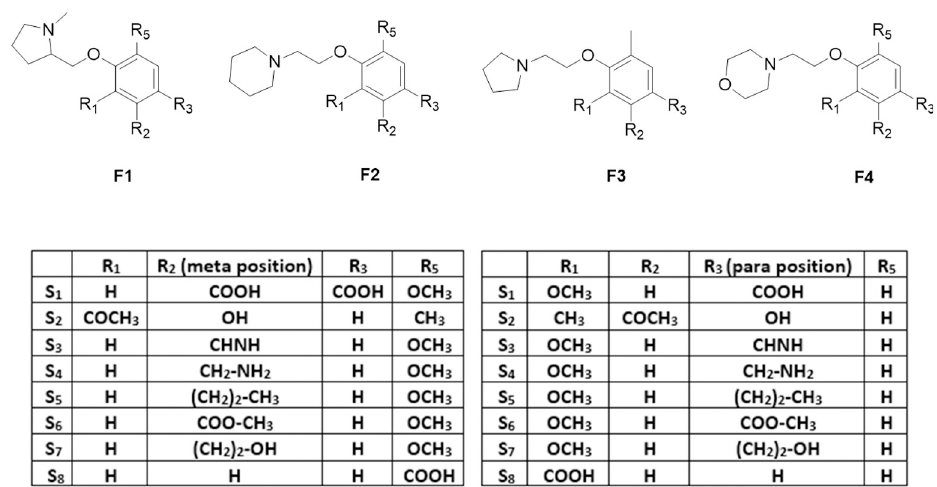
Fig 1. Chemical structures of ligands designed with heterocyclic amines; methyl pyrrolidine (F1), piperidine (F2), pyrrolidine (F3) and morpholine (F4) distanced 3 atoms away from the aromatic backbone. Substitution of the aromatic system with benzoic acid (S1 and S8), hydroxybenzoic acid (S2), phenylmetanimine (S3), phenylmethanamine (S4), butylbenzene (S5), methyl benzoate (S6) and phenyl ethanol (S7) in a -m or -p position related to the heterocyclic